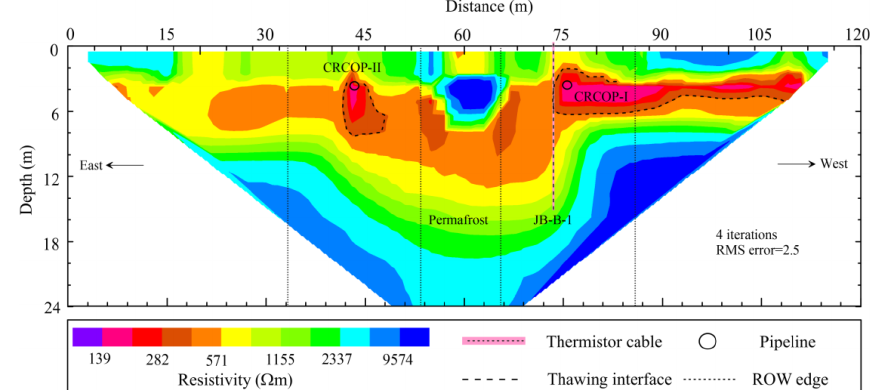
Figure 11. Inversion results of electrical imaging along the P-JB-1 profile at the JB site along the China–Russia crude oil pipeline (CRCOP) I in the northern part of Northeast China in April 2018.